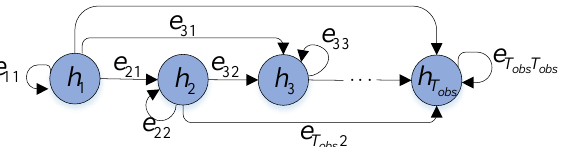
Figure 3. The illustration of message passing mechanism of each pedestrian in direct temporal graph.